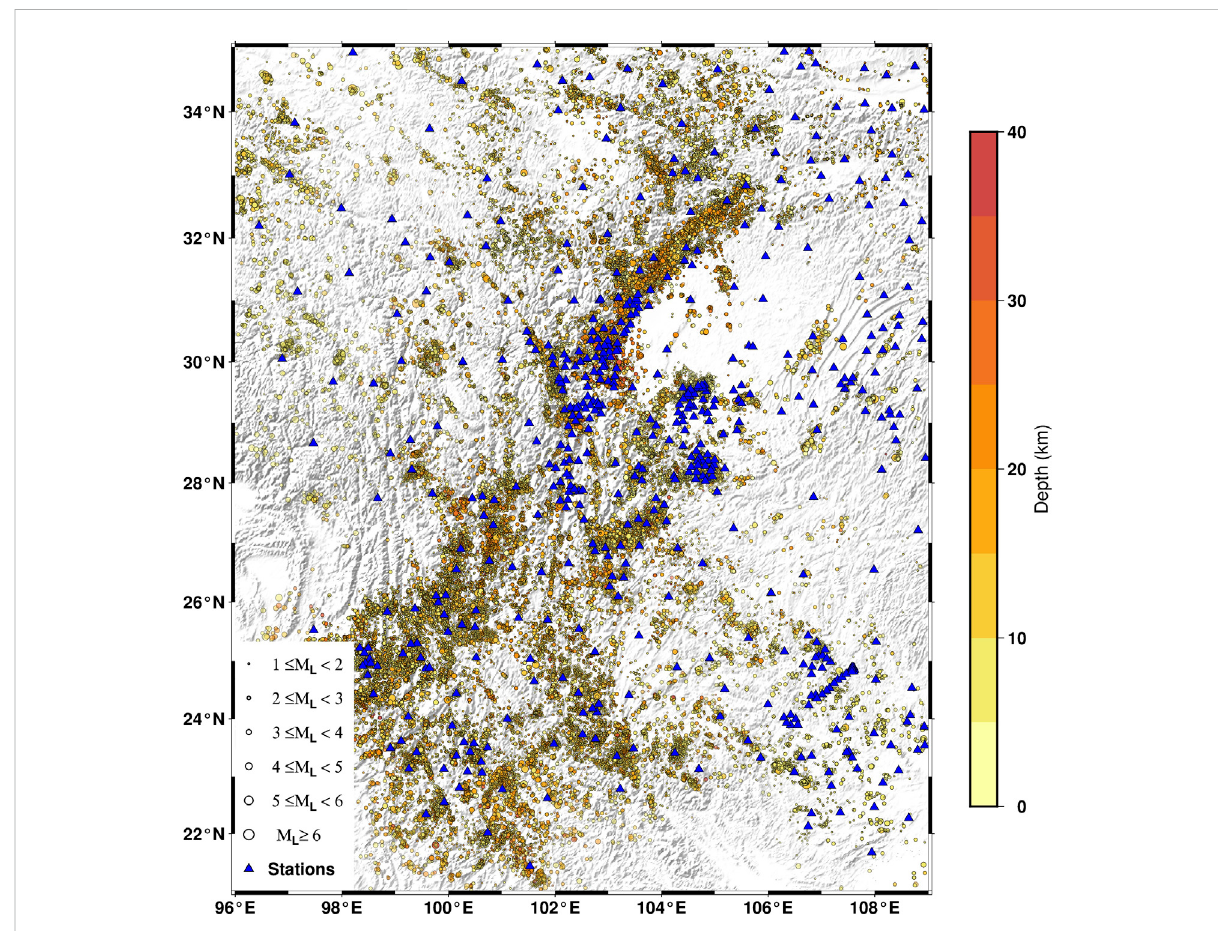
FIGURE 1 Distribution of seismic stations and earthquake epicenters in Sichuan-Yunnan region.